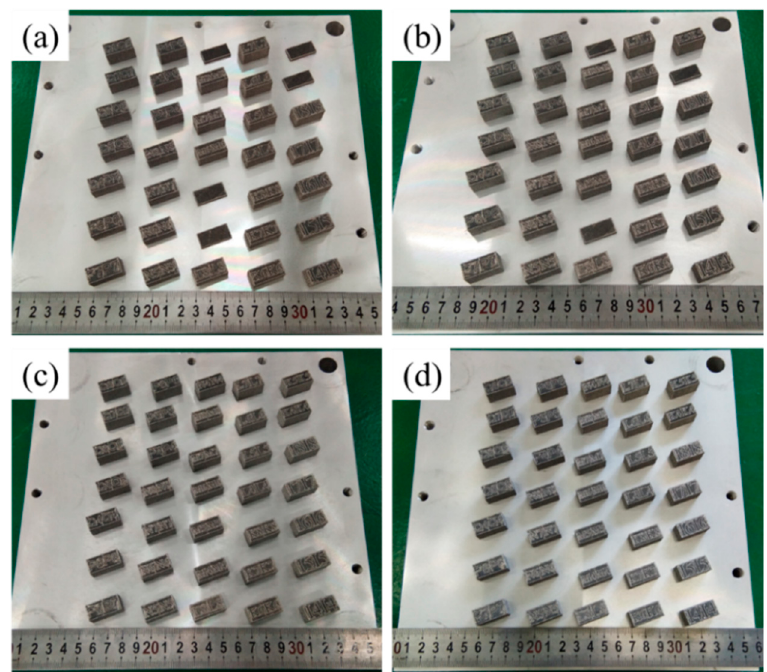
Figure 3. Al-6.2Zn-2Mg-xSc-xZr alloy sample fabricated by SLM, ( a ) sample 1, ( b ) sample 2, ( c ) sample 3, ( d ) sample 4.